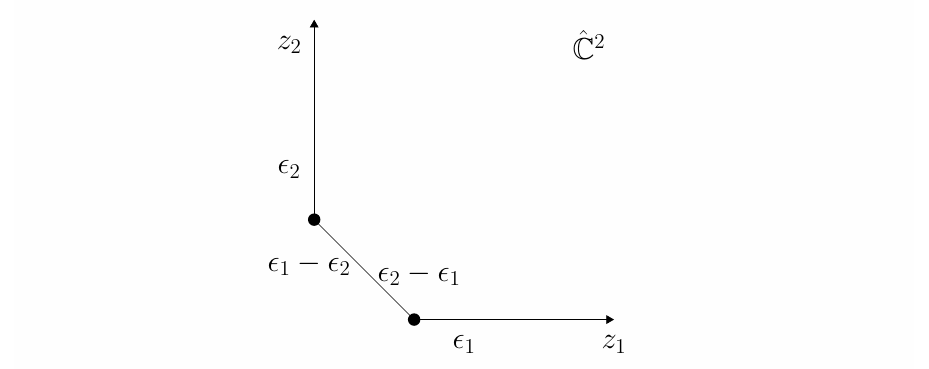
Figure 2 . The toric diagram of ^ C 2